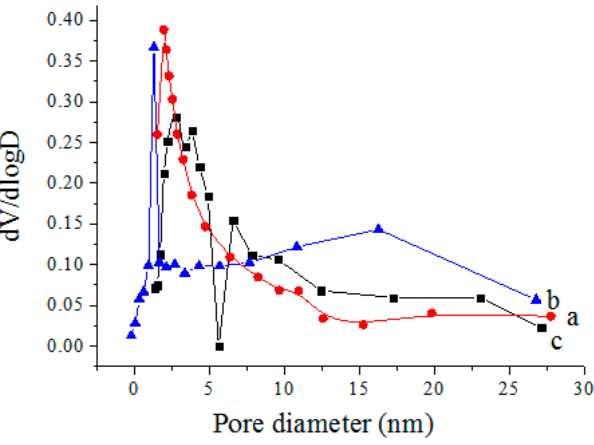
Figure 6. BJH pore size distribution curves of aerogels: ( a ) CS, ( b ) GO, and ( c ) CS / GO. Table 2. Hole structure analysis of the samples.